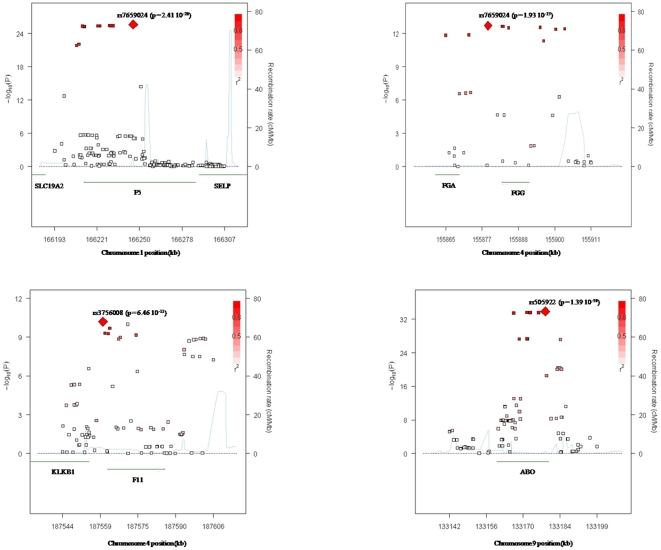
Regional association plots at the four genome-wide significant loci using imputed SNPs.Four genome-wide significant loci were F5 (top left), FGG (top right), F11 (bottom left) and ABO (bottom right). These plots were drawn from the SNAP software [25].